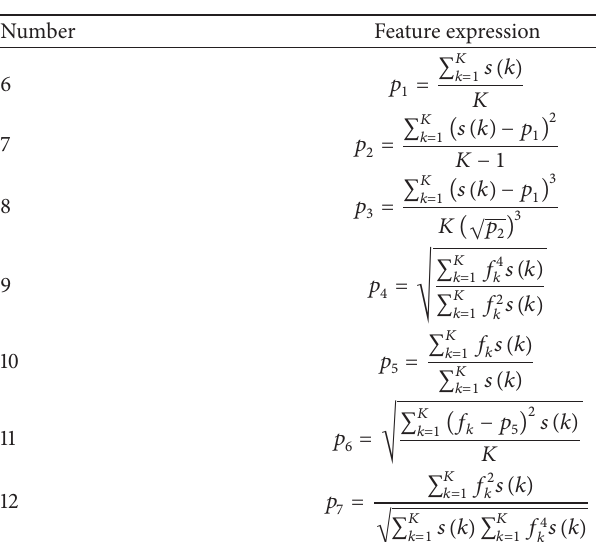
Table 3: Experimental parameters of rolling